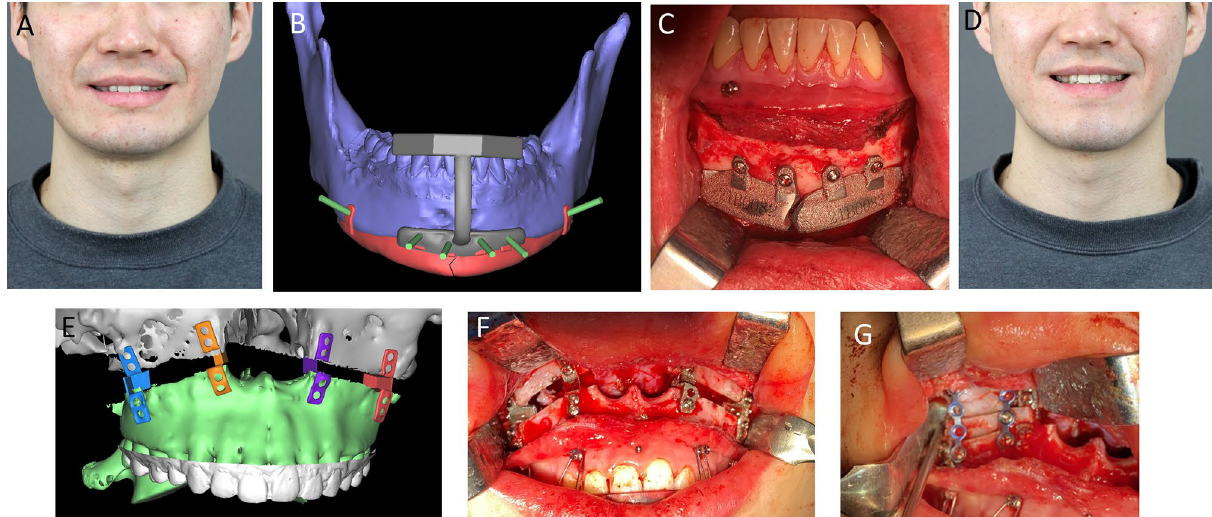
Figure 4. Restoring surgery. ( A ) A 31-year-old male patient underwent genioplasty at a local clinic. He wanted to restore the length of the jaw. ( B ) Computer-aided design of a chin implant and guide. ( C ) Chin augmentation, with two-piece titanium chin implants, was performed. ( D ) Three months after the surgery, the patient was satisfied with the chin length. ( E , F ) A 21-year-old woman wanted her upper and lower jaws to be restored